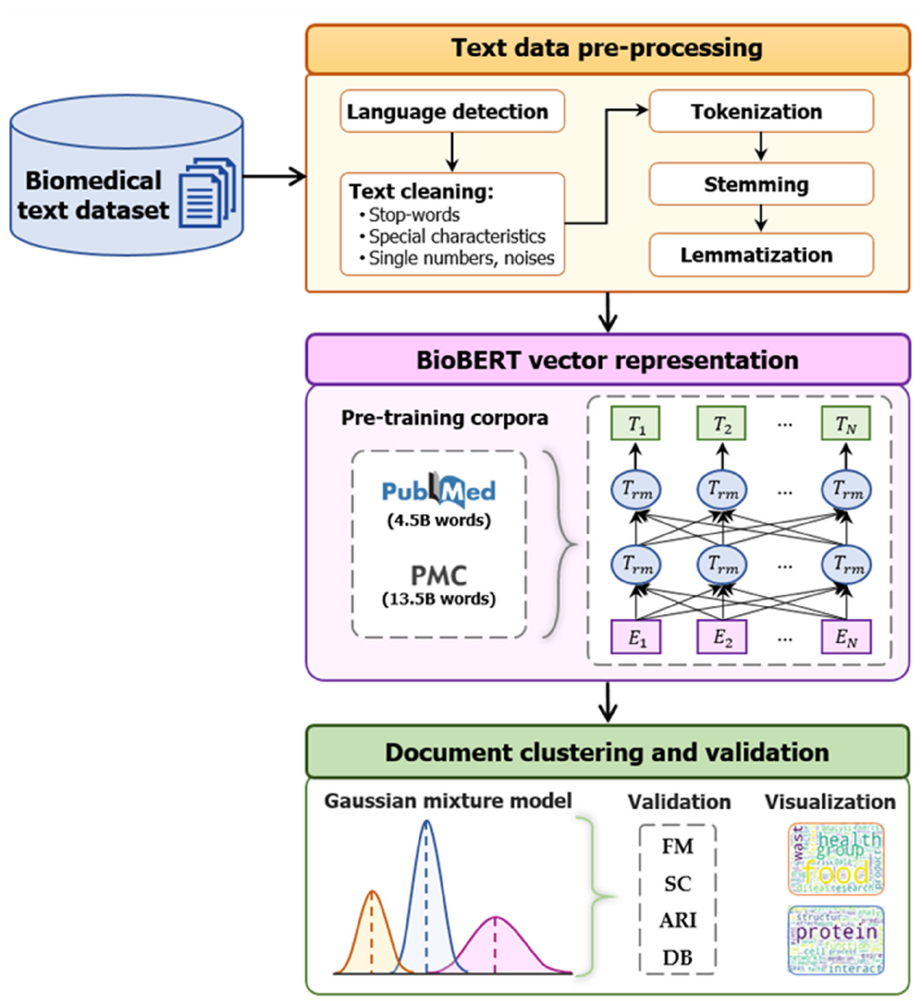
Figure 1. Contextualized bidirectional encoder representations from transformers-based clustering framework for biomedical documents. framework for biomedical